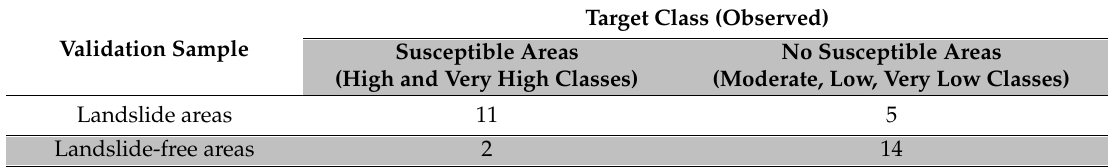
Table 4. Confusion matrix of LS map